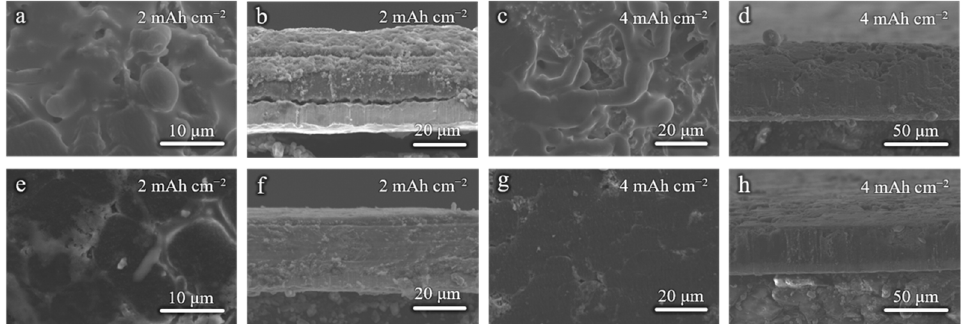
Figure 3. Surface and cross-sectional SEM images of ( a , b , e , f ) 2 mAh cm − 2 and ( c , d , g , h ) 4 mAh cm − 2 Li deposition on the ( a – d ) commercial Cu foil and ( e – h ) Cu −